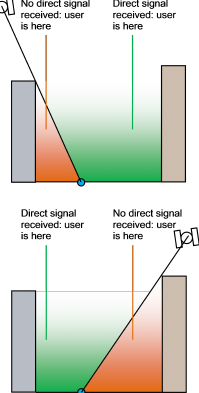
Figure 1: Error in GNSS